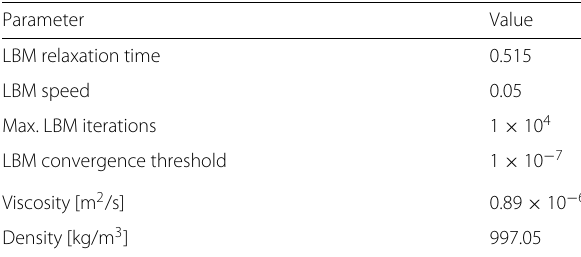
Table 3 D2Q9 LBM simulation parameters